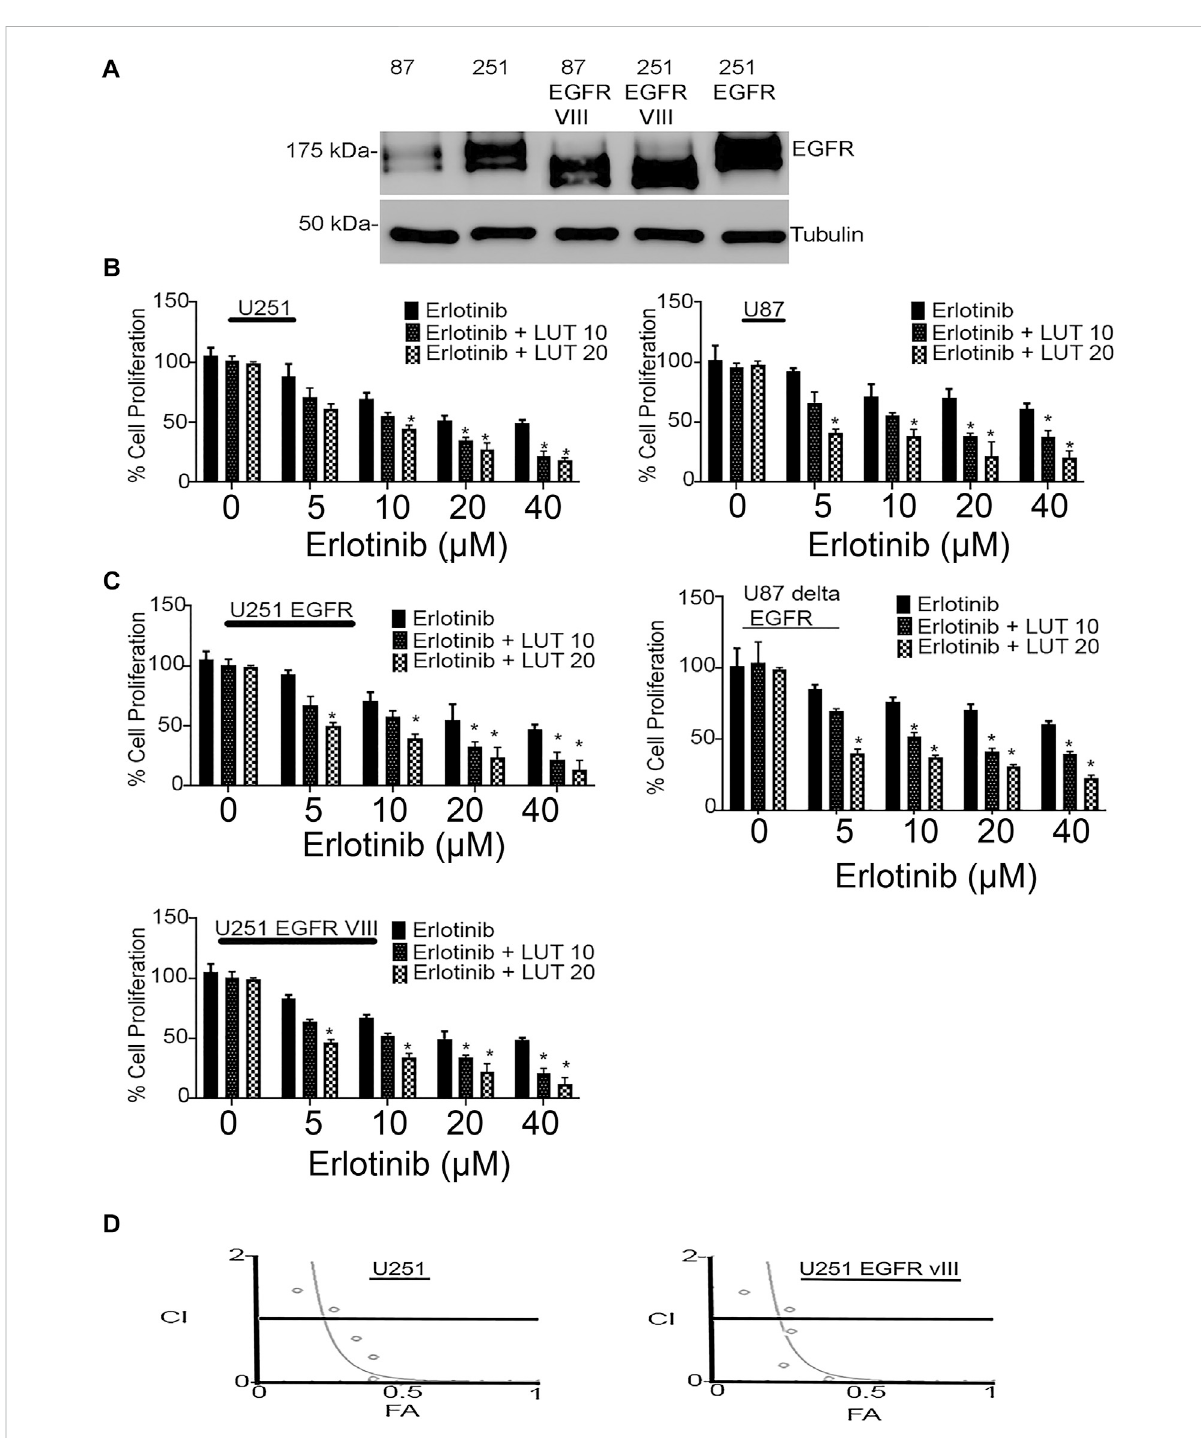
FIGURE 2 Antiproliferative effects of erlotinib and luteolin in glioblastoma cell lines. (A) Westernblot analysis of theexpressionpro fi le of EGFR, EGFRvIII in glioblastoma cells expressing the EGFR and the truncated EGFR. (B) Combined effects of erlotinib and luteolin treatment in U87 and U87 Δ EGFR induced a robust inhibitory effect on glioma cell proliferation as measured by MTT assay. The observed decrease in cellular growth was concentration-dependent in all the glioma cell lines tested. * p < 0.05 versus erlotinib alone. (C) Combined effects of erlotinib and luteolin treatment in U251 and U251EGFR, and U251 EGFR vIII induced a robust inhibitory effect on glioma cell proliferation as measured by MTT assay. The observed decrease in cellular growth was concentration-dependent in all the glioma cell lines tested. * p < 0.05 versus erlotinib alone. (D) Drug combination index showing synergistic effects of the combination of erlotinib and luteolin in glioblastoma cells. CI < 1, CI = 1, CI > 1 indicates synergistic, additive, and antagonistic effects,